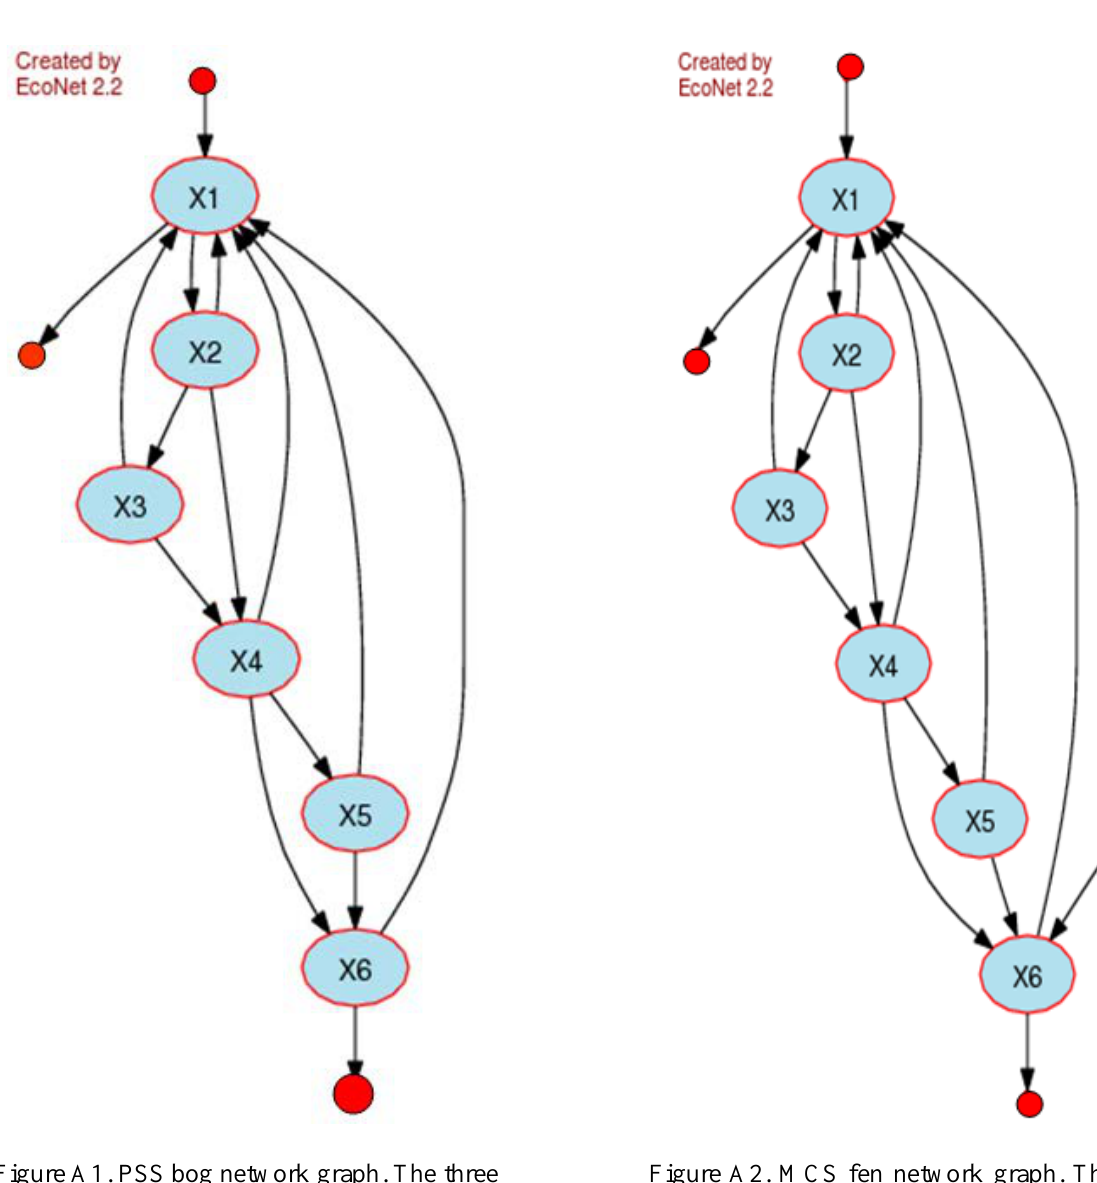
Figure A1. PSS bog network graph. The three red dots indicate external carbon flows in the mire ecosystem.